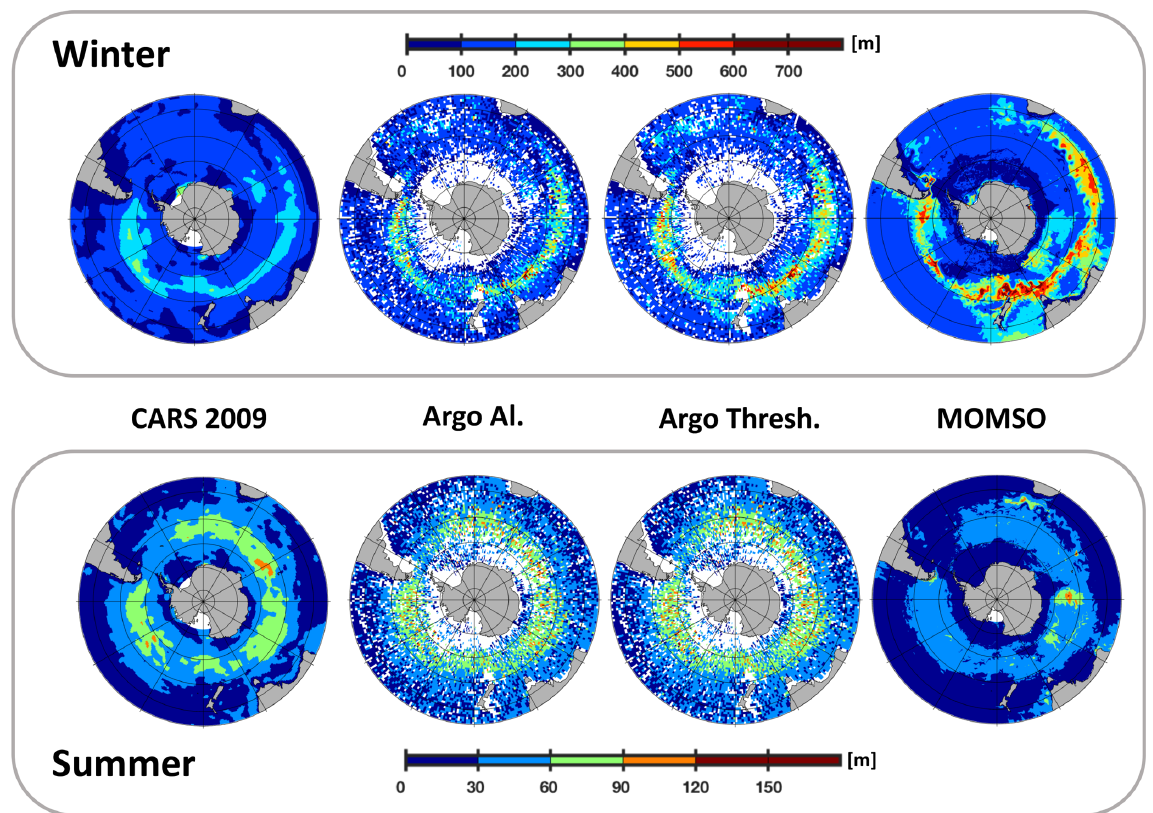
Figure 10. Surface mixed layer depth in units of meters. The upper (lower) line refers to austral winter (summer). The columns refer to (observed) CARS 2009 climatology based on Condie and Dunn (2006), Argo Al. and Argo Thresh. computed from (observed) profiles of Argo floats using two different methods by Holte et al. (2017) and our simulation (MOMSO). White patches in Argo Al. and Argo Thresh. denote missing